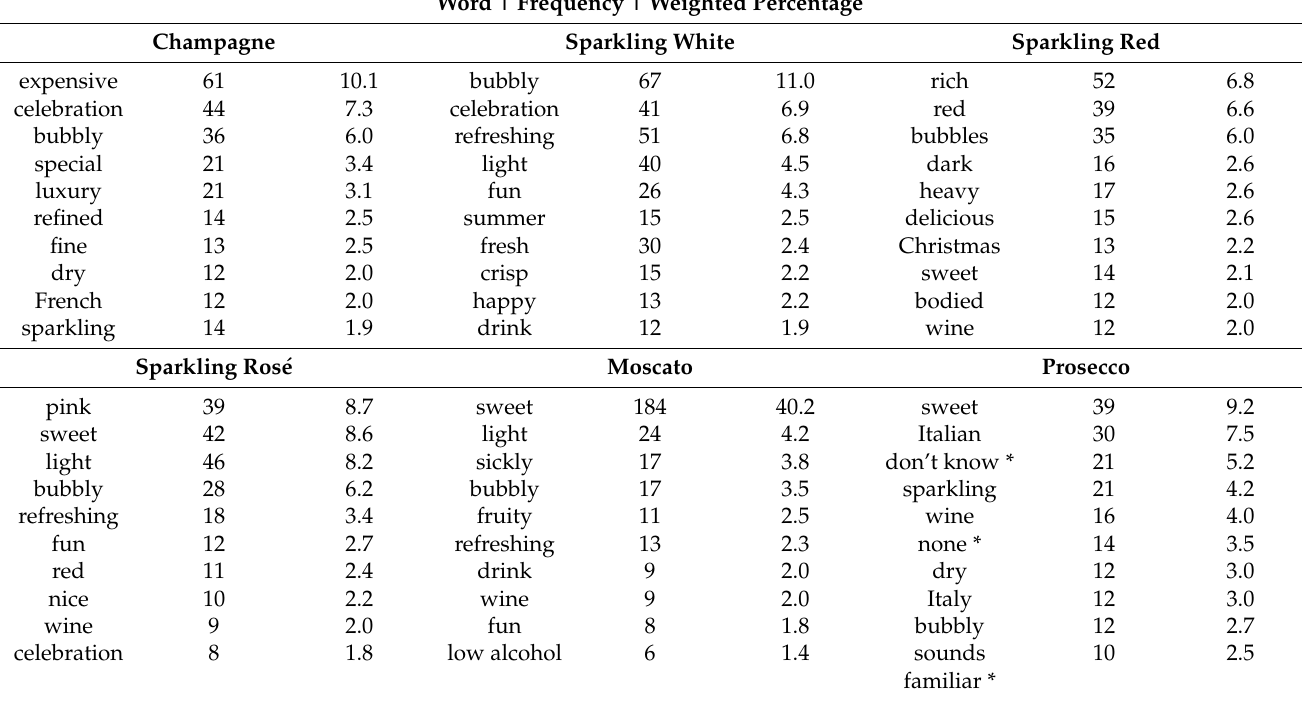
Table 4. Frequencies and weighted percentages of the top ten words (and their synonyms) that consumers associated with different sparkling wine